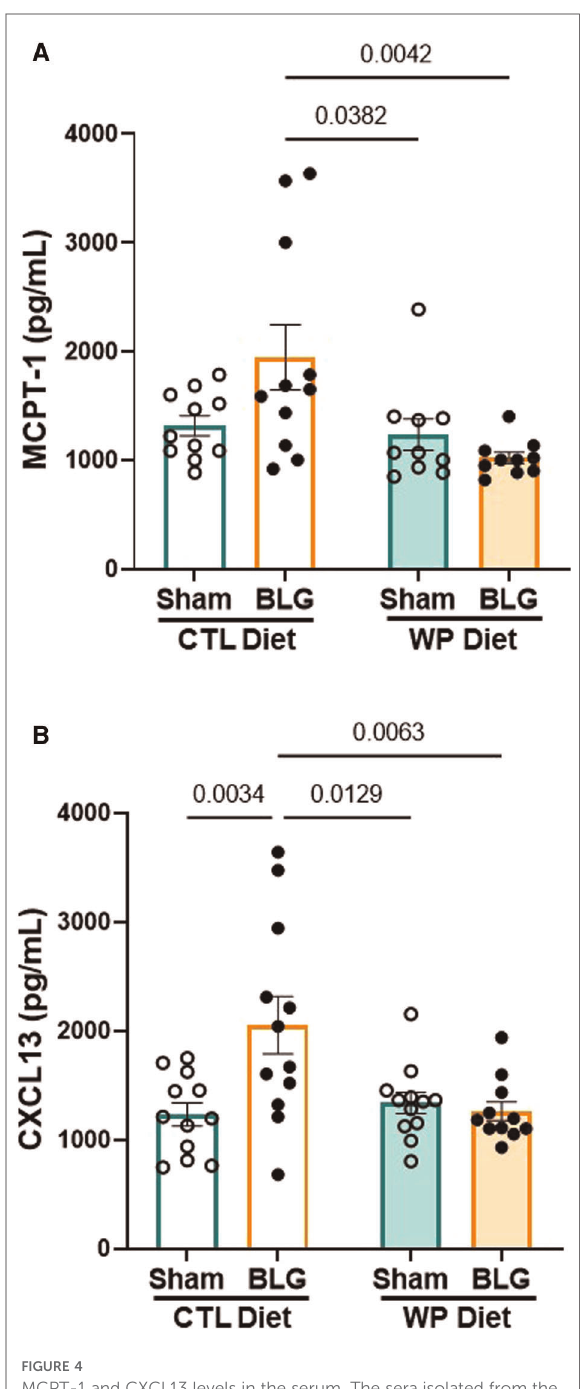
FIGURE 4 MCPT-1 and CXCL13 levels in the serum. The sera isolated from the terminal blood of sham and BLG-sensitized mice were used to quantify MCPT-1 ( A ) and CXCL13 ( B ). The concentrations of the analytes were determined from respective standard curves. Values indicate the group average±SEM pg/ml. Signi fi cant p -values are shown. Two-way ANOVA, n =10 – 12 per group. One outlier identi fi ed by the ROUT method (Q=1%) was removed from the fi nal analysis for MCPT-1 ( A